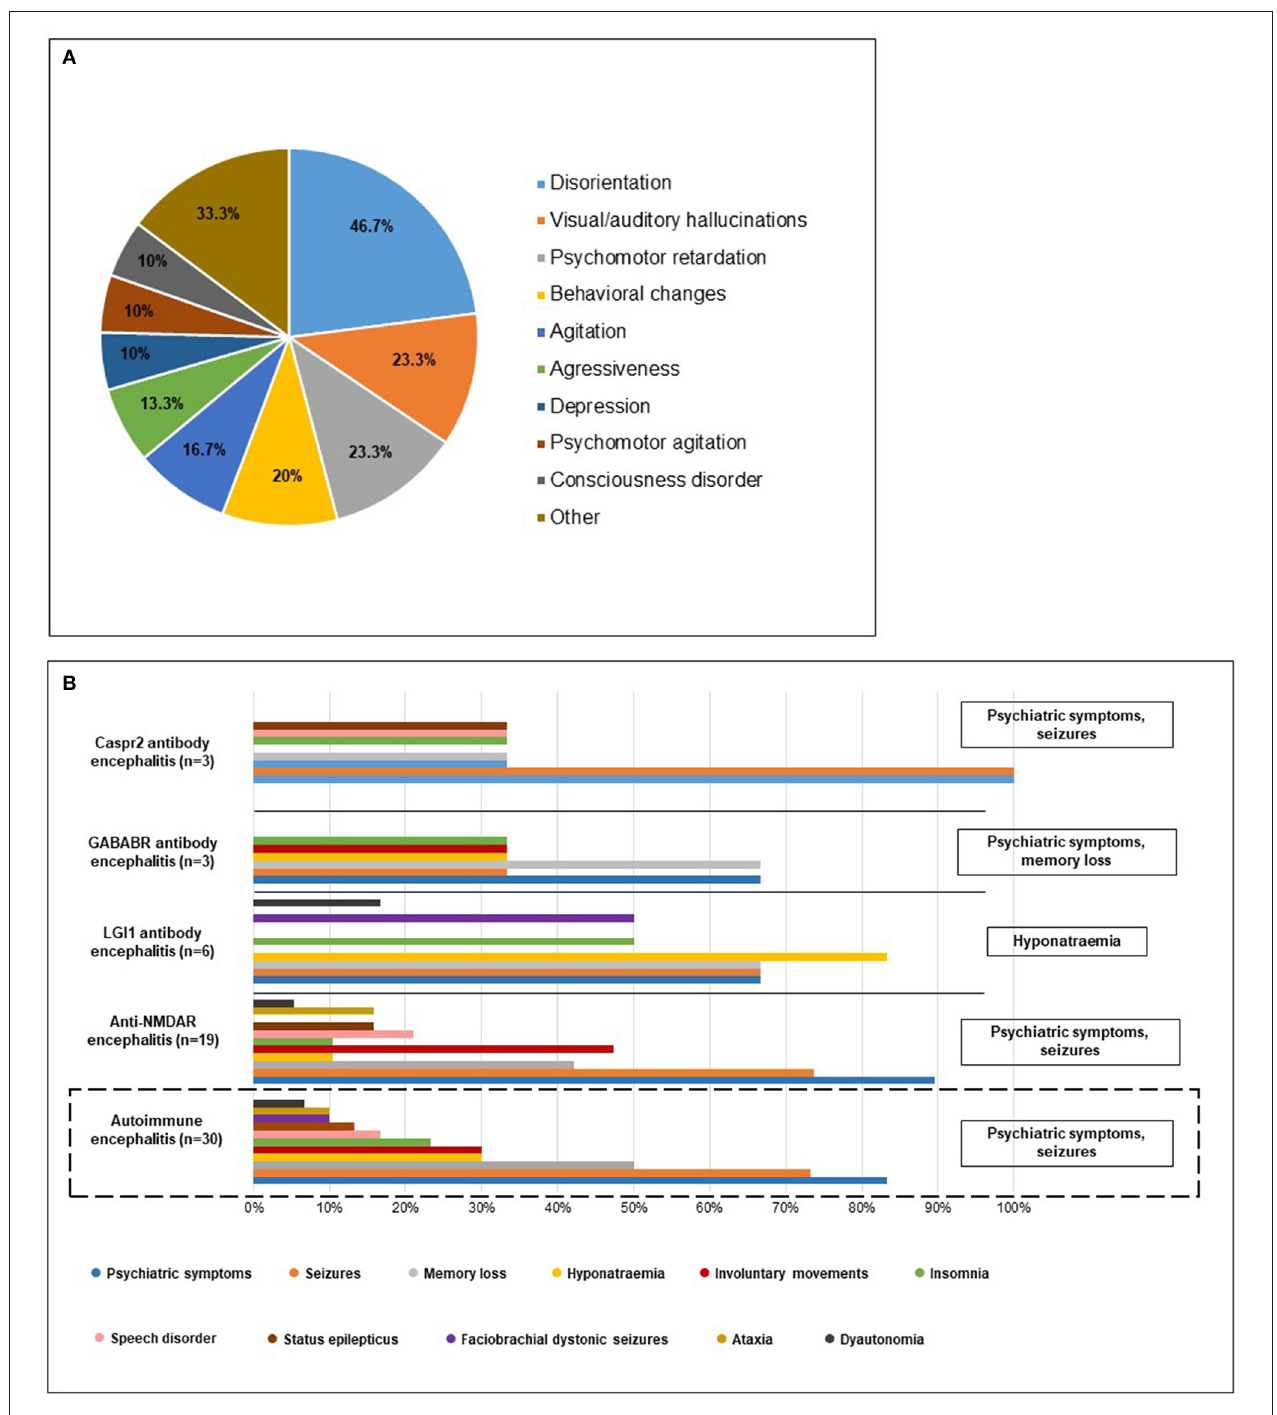
FIGURE 1 | (A) Psychiatric symptoms of AE patients. The diagram shows the distribution of psychiatric symptoms among the 30 AE patients in our cohort. Most common symptoms included disorientation, visual/auditory hallucinations, psychomotor retardation and behavioral changes. Frequency of rare psychiatric symptoms such as anxiety, cognitive deficit, catatonia, apathy, hypersexuality, and mutism are included in “Other.” (B) Characteristic clinical symptoms of AE patients. The bars show the frequency of different clinical features of AE patients. The diagram at the bottom shows that psychiatric symptoms and seizures were the most common in the 30 AE patients in our cohort. The other diagrams indicate distribution of clinical features separately in different AE types. Different distribution of clinical symptoms was observed in anti-LGI1 and anti-GABABR patients: in LGI1 encephalitis hyponatraemia and in GABABR encephalitis besides psychiatric symptoms memory loss was among the most common